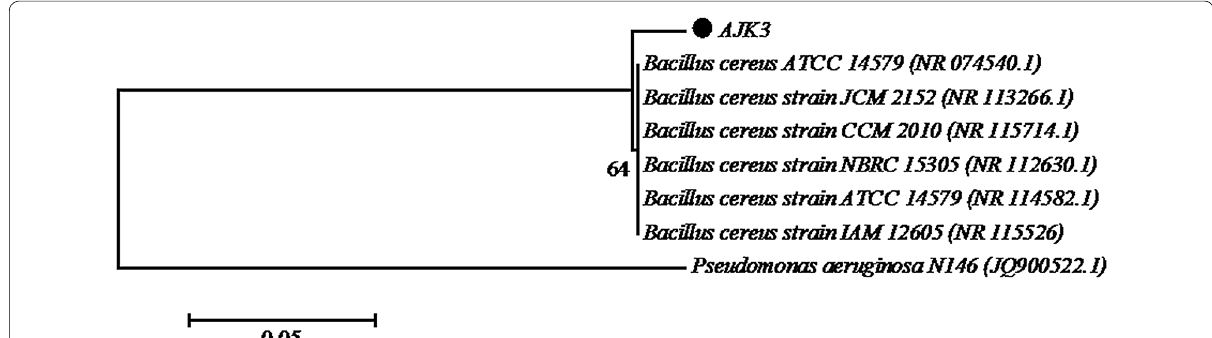
Fig. 2 Dendrogram showing the phylogenetic relationship between the partial 16S rRNA gene sequences of the isolate AJK3 and related bacterial species. The scale bar indicates the sequence divergence. The strain Pseudomonas aeruginosa N146 was used as an outgroup